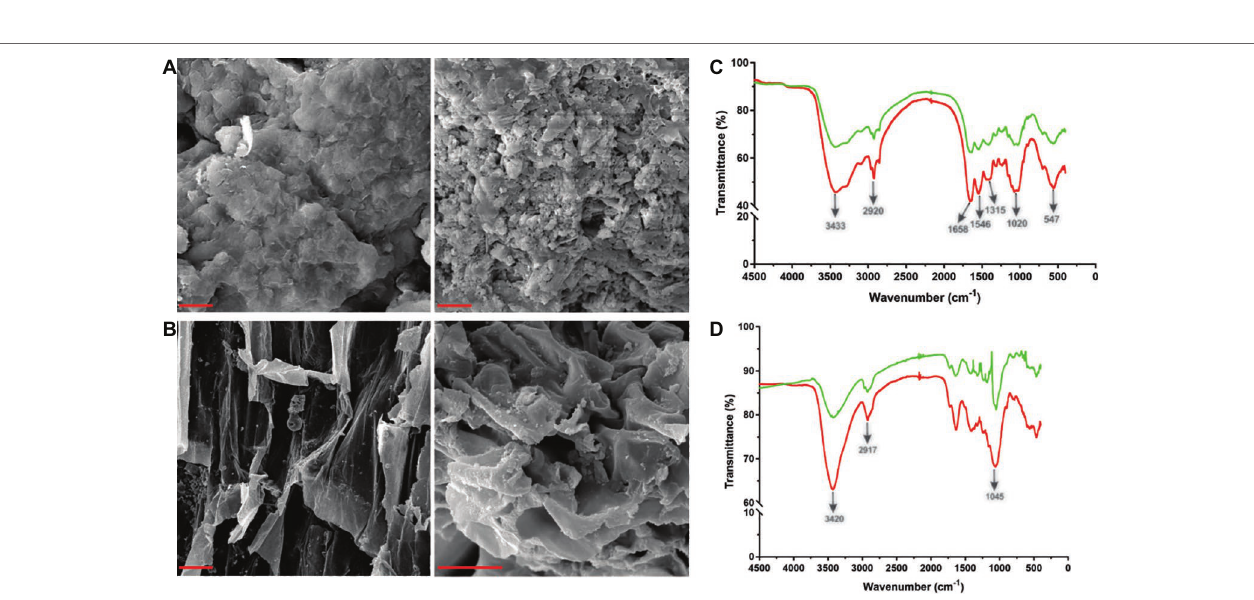
FIGURE 4 | Scanning electron microscopy (SEM) and Fourier transform infrared spectroscopy (FT-IR) analysis of shrimp shell and rice straw incubated with Tk-ChiA. (A) After incubation of Tk-ChiA and shrimp shell at the optimal enzyme reaction conditions (pH 7.0, 65 ° C) for 5 h, the sample was observed by SEM with 1,000× amplification (right). The control sample was exposed to an equal volume of buffer (left). Scale bar (red), 5 μm. (B) After incubation of Tk-ChiA and rice straw at the optimal enzyme reaction conditions (pH 7.0, 65 ° C) for 5 h, the sample was observed by SEM with 1,000× amplification (right). The control sample was exposed to an equal volume of buffer (left). Scale bar (red), 5 μm. FT-IR spectra of shrimp shell (C) and rice straw (D) with enzymatic treatment (red) and without enzymatic treatment